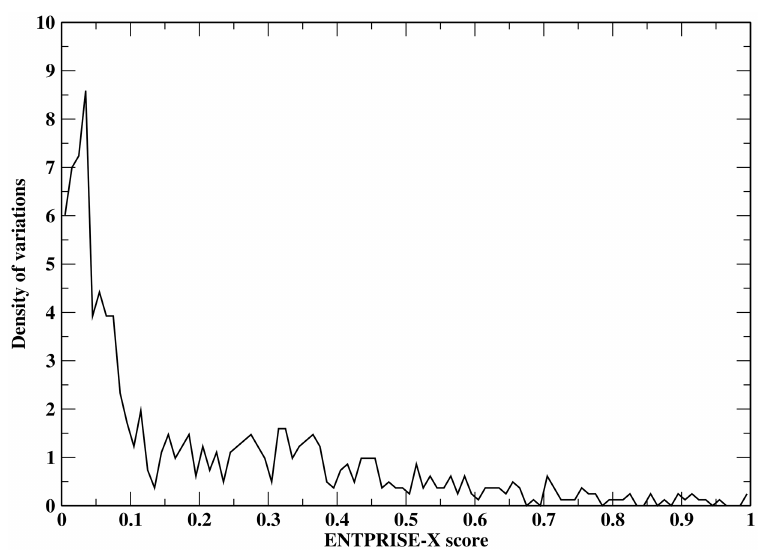
Fig 3. Distribution of ENTPRISE-X scores for the neutral variations in the VEST-indel test set. The area under the curve is normalized to one.